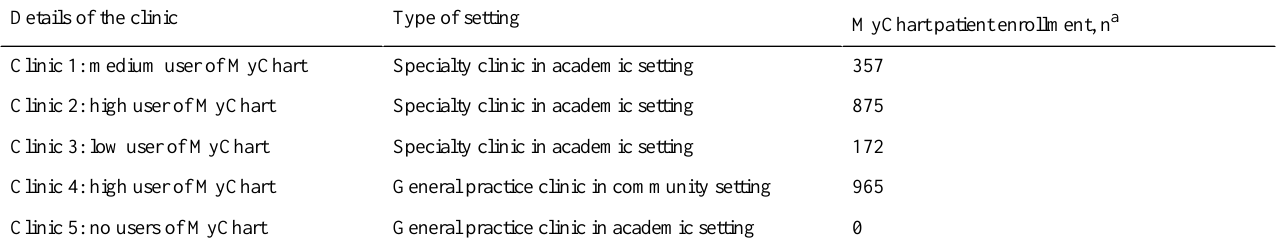
Table 1. Case study characteristics.